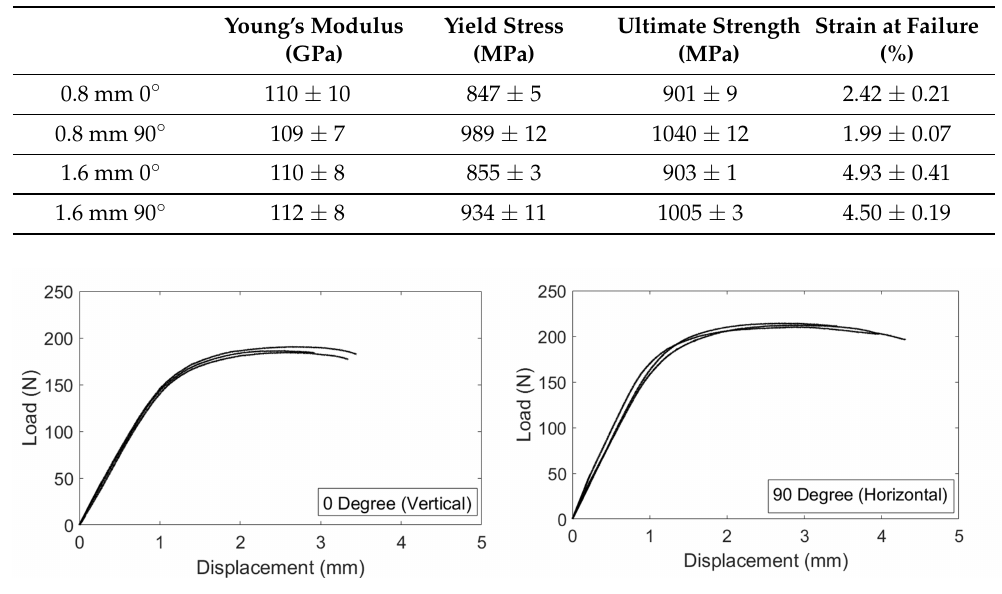
Figure 10. Load-deflection curves for 0 ◦ and 90 ◦ build orientation specimens in the bending test.